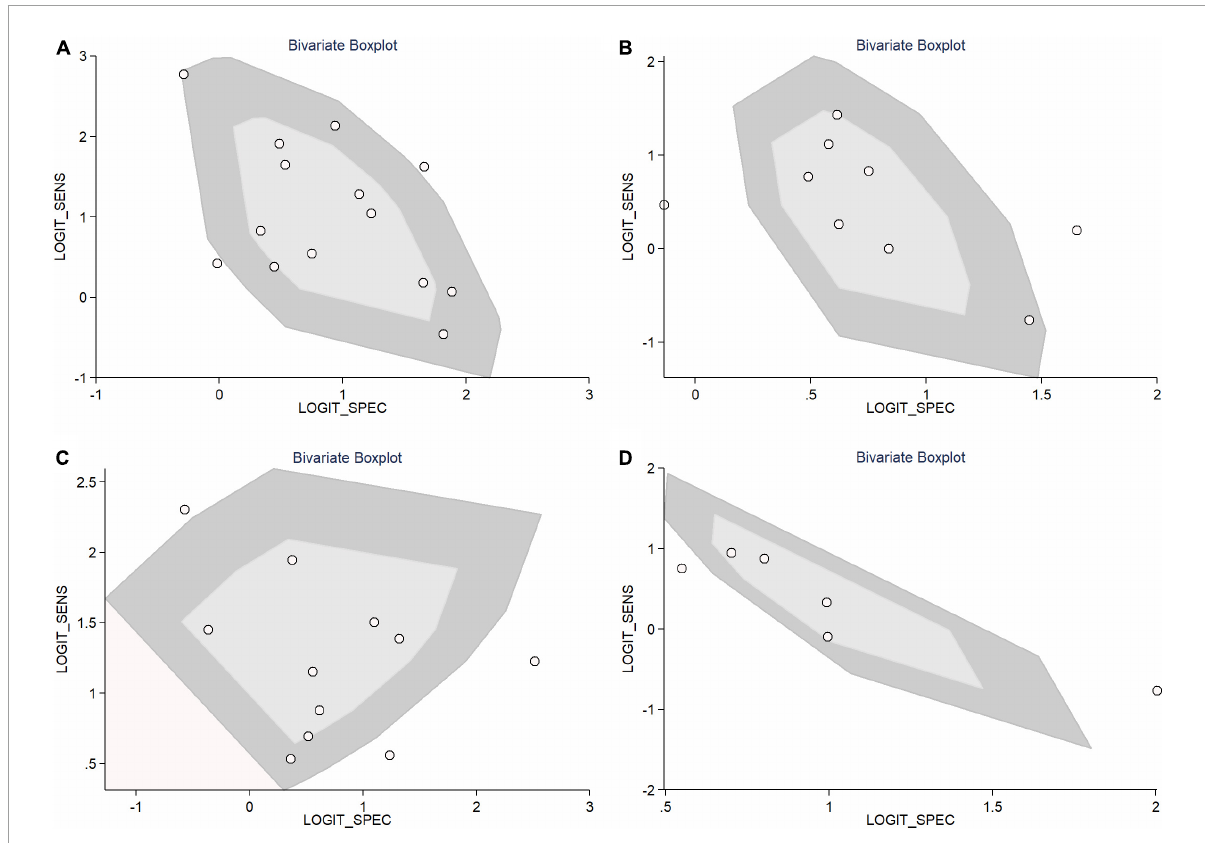
FIGURE7 Bivariate box plot (A) NLR; (B) PLR; (C) CRP; (D) NLR and PLR